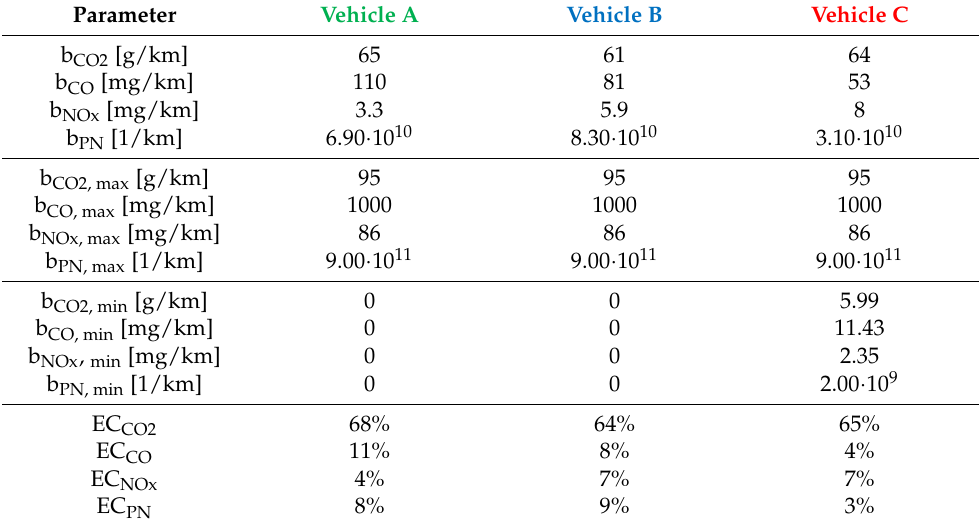
Table 9. Real values of the road exhaust emissions (b j ), theoretically determined maximum value (b j, max ) minimum value (b j, min ), and the environmental assessment (EC j ) for individual plug-in hybrid vehicles.